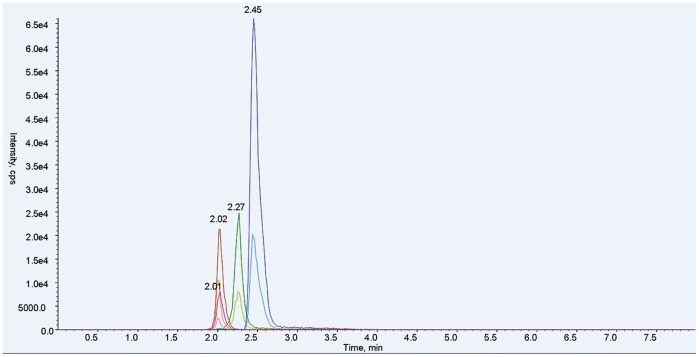
Representative UFLC-MS/MS MRM chromatogram of albendazole and metabolites.Peaks with the same retention time and approximate color are fragment ions from the same target analyte. Retention times: ABZ, blue, 2.45 min; ABZSO, red, 2.01 min; ABZSO2, orange, 2.02 min; ABZSO2-NH2, green, 2.27 min.